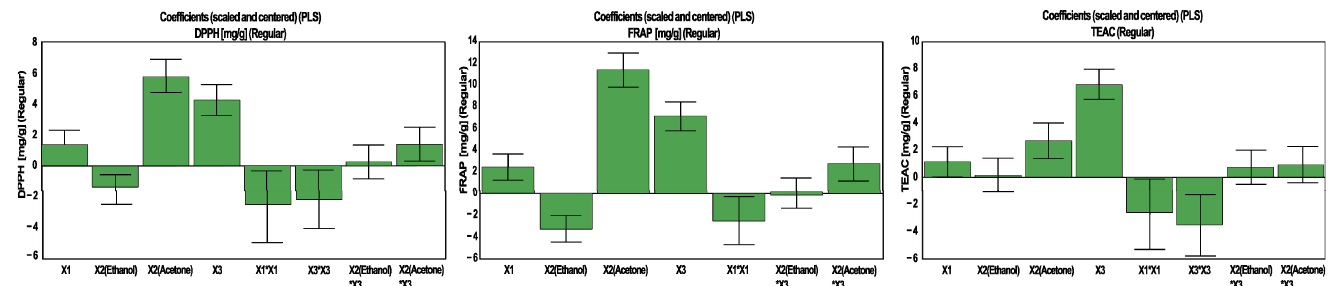
Figure 6. Influence of working conditions on the DPPH, FRAP and TEAC assays of walnut flower extracts, presented as scaled and centered coefficient plots. X 1 —extraction time (min); X 2 —solvent; X 3 —water in solvent (%, v/v ).